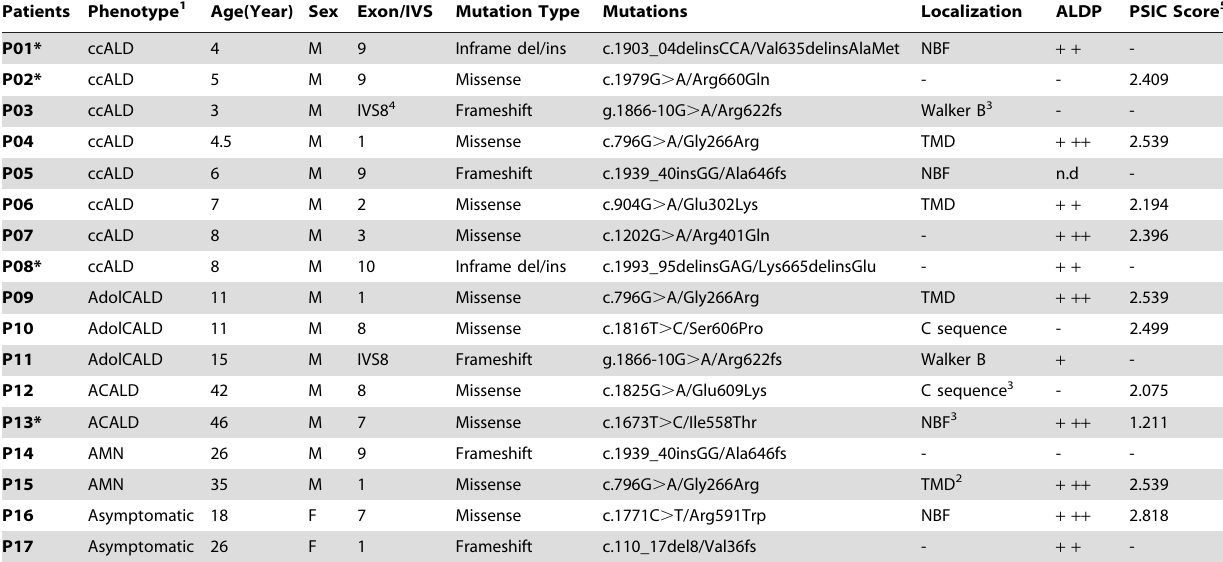
Table 3. Molecular analysis of 17 patients with X-linked adrenoleukodystrophy